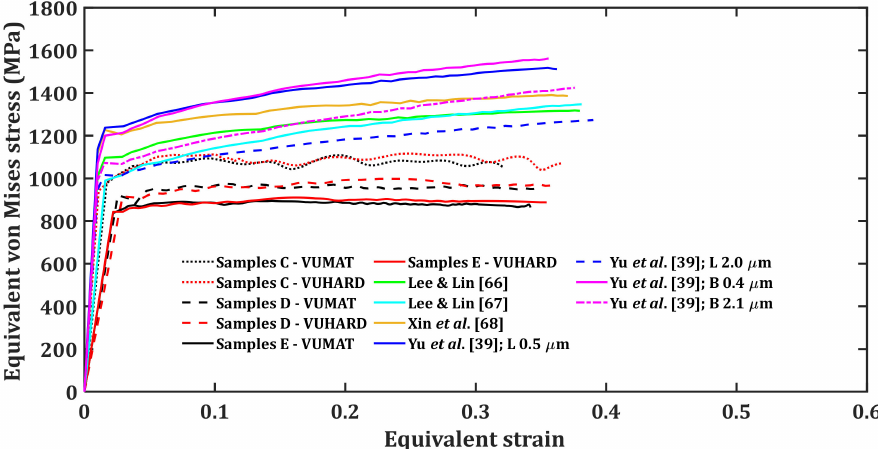
Figure 13. Results of SHPB test simulation at an impact velocity of 15 m/s and a temperature of 25 ◦ C with the test samples modelled using various sets of J–C model parameters (note: B and L stand for bimodal and lamellar microstructures, respectively) and the numerical models developed in the present